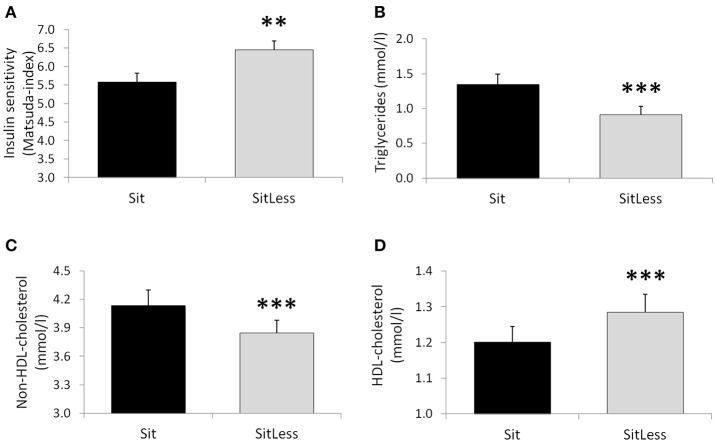
Insulin sensitivity (Matsuda-index; A), triglycerides (B), non-HDL-cholesterol (C) and HDL-cholesterol (D) on the morning after the activity regimens. Means and standard error bars are presented. **p < 0.01; ***p < 0.001.